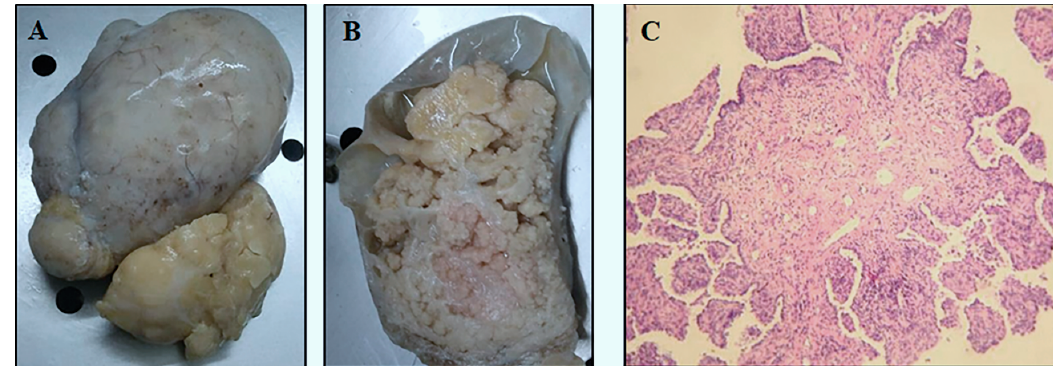
Figure 1. A 59-year-old former smoker male patient was admitted to the hospital for a persistent dry cough in the last few weeks. In the medical history, a treated hypertensive cardiomyopathy was reported. At chest X-Ray a nodule of 9 cm in maximum diameter was revealed. A chest CT scan was also performed, highlighting an excavated mass that arose from the posterior part of the lower right lobe visceral pleura. Radiological examination ruled out close and distant metastases. The patient underwent thoracotomy with tumorectomy without previous biopsy. At surgery, the tumor appeared encapsulated and was strictly connected to the visceral pleural, thus suggesting a mesothelial origin. At macroscopic examination, the tumor measured 9.5 × 7 × 4.5 cm and it was composed of papillary solid structures in the context of multicystic spaces with clear liquid content ( A , B ). Histologically, lung samples showed a subpleural lesion surrounded by a fibrous pseudocapsule. The neoplasia was characterized by a single layer of columnar and cuboidal epithelial cells lining moderately cellular fibrovascular cores, composed of plump, homogeneous spindle cells in a streaming fashion, and a moderate lymphocytic infiltration. The lining epithelial cells demonstrated minimal cytological and nuclear atypia, with no mitotic figures. Neither tertiary structures, as branching of papillary fronds without concomitant fibrovascular stromal, nor lepidic aspects were seen ( C , haematoxylin and eosin, original magnification, × 100). Microfoci of tumor invasion in the pseudocapsular tissue and visceral pleura were described. The differential diagnosis included: sclerosing hemangioma, pulmonary papillary adenoma, papillary adenocarcinoma, and pseudoglandular carcinoid tumor. The diagnosis of pulmonary adenofibroma was also considered.